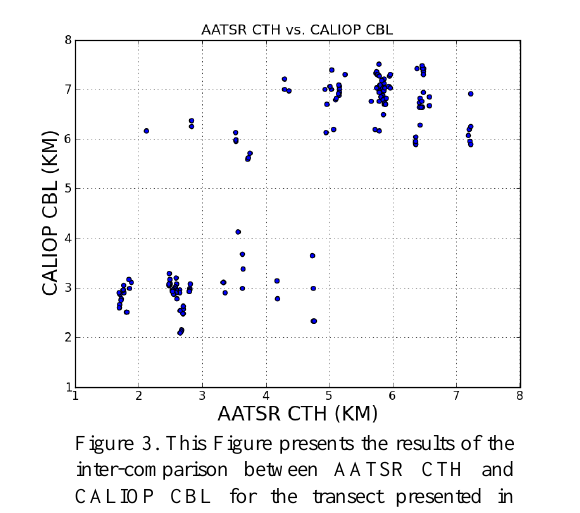
inter-comparison between AATSR CTH and Figure 1c